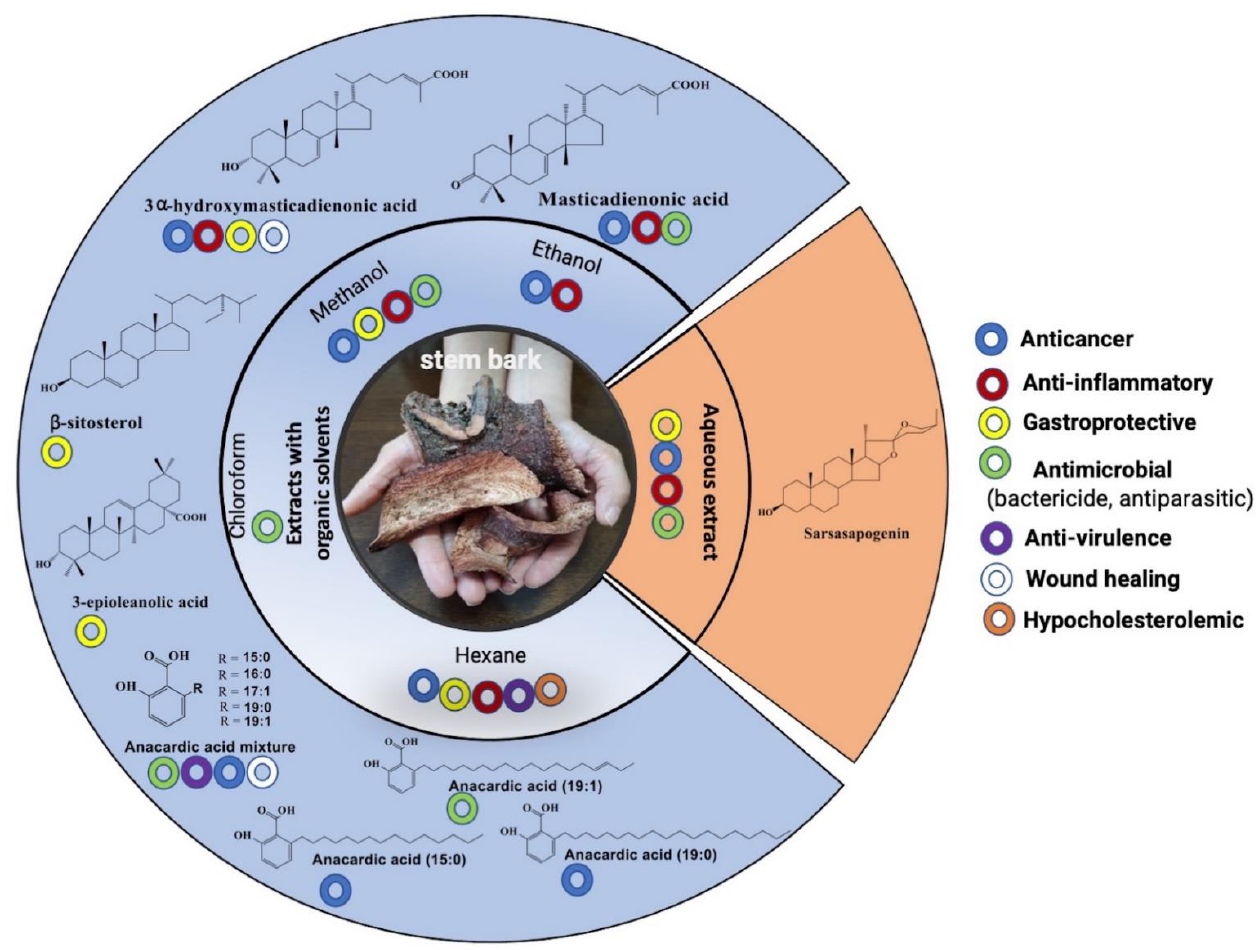
Figure 7. Pharmacological properties of A. adstringens stem bark extracts and main bioactive metabolites. Anticancer [5 – 7,42,43,45,49 – 55], anti-inflammatory [7,48], gastroprotective [57 – 61], antimicrobial [5,9,46,47,62,63], anti-virulence [64,65], wound healing [10], and hypocholesterolemic activity [44].